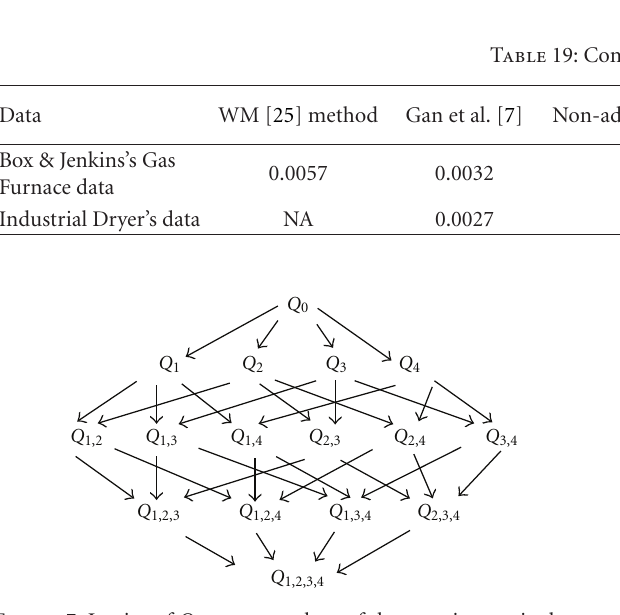
Figure 7: Lattice of Q - measure values of the constituent singleton sets with D =